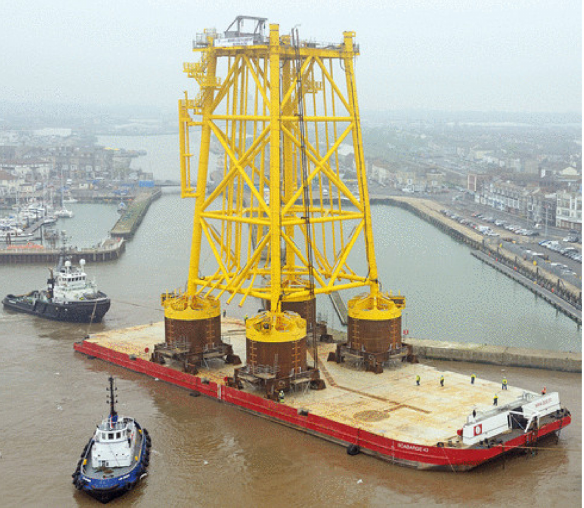
Figure 1. Photograph of tetrapod bucket foundations (courtesy of Statoil